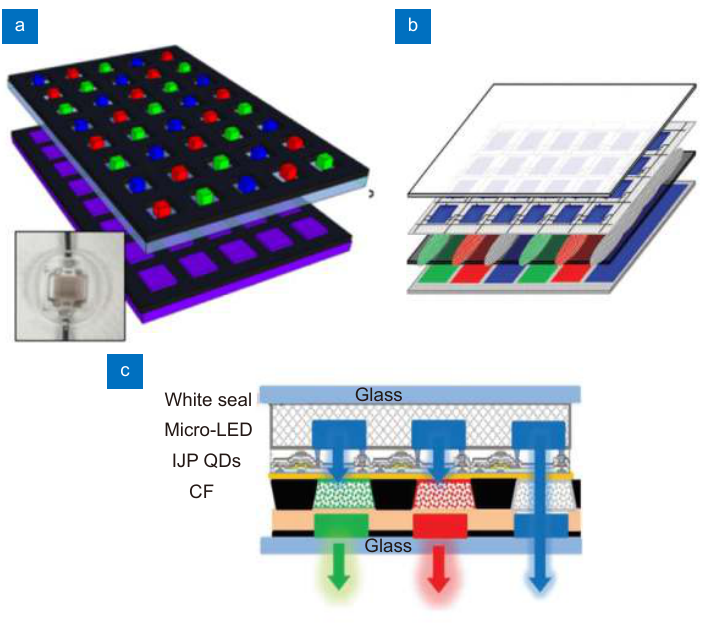
Fig. 5 | ( a ) Sketch of the full color RGB QD-converted micro-LED array based on an UV backlight module and the device image (inset). ( b ) Schematic illustration of the full-color prototype . ( c ) Cross-section structure diagram of the prototype. Figure reproduced with permission from: (a) ref. 42 , American Chemical Society; (b, c) ref. 45 , John Wiley and Sons.